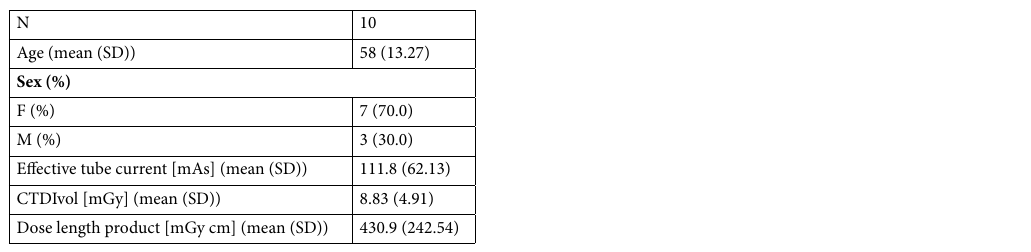
Table 1. Patient